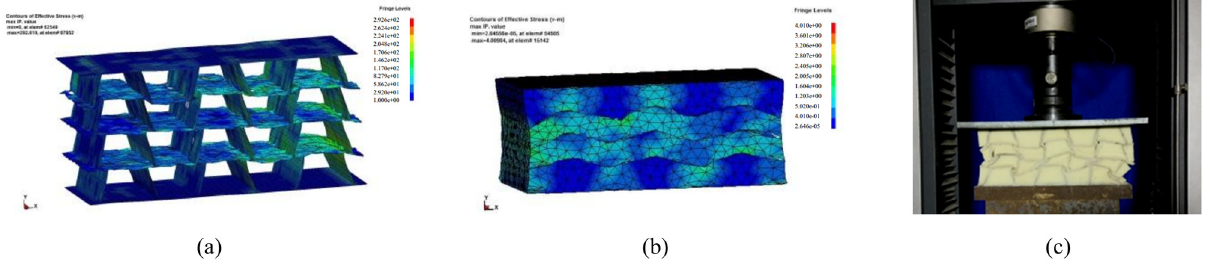
Figure 15: Strain and stress of specimen TS - T - A75: ( a ) GFRP, ( b ) PU foam, ( c ) quasi - static